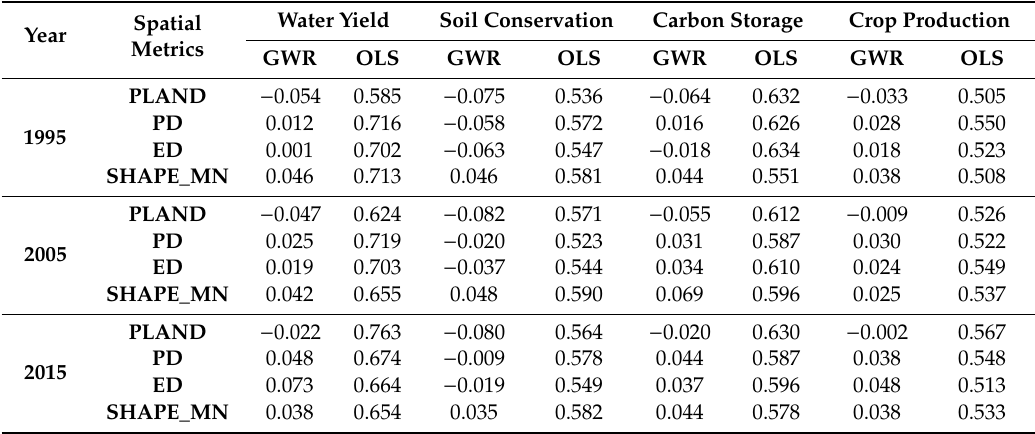
Table 9. Comparison of Moran’s I between GWR and OLS